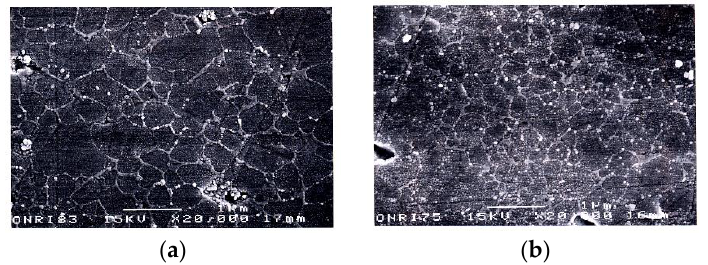
Figure 23. SEM photos of etched surfaces: ( a ) SPS-consolidated SiC (2073 K, 30 MPa); ( b ) HP-consolidated SiC (2273 K, 30 MPa).